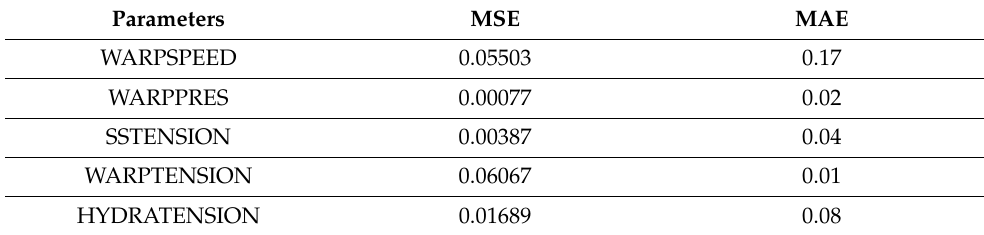
Table 9. Ridge regression results for the warping